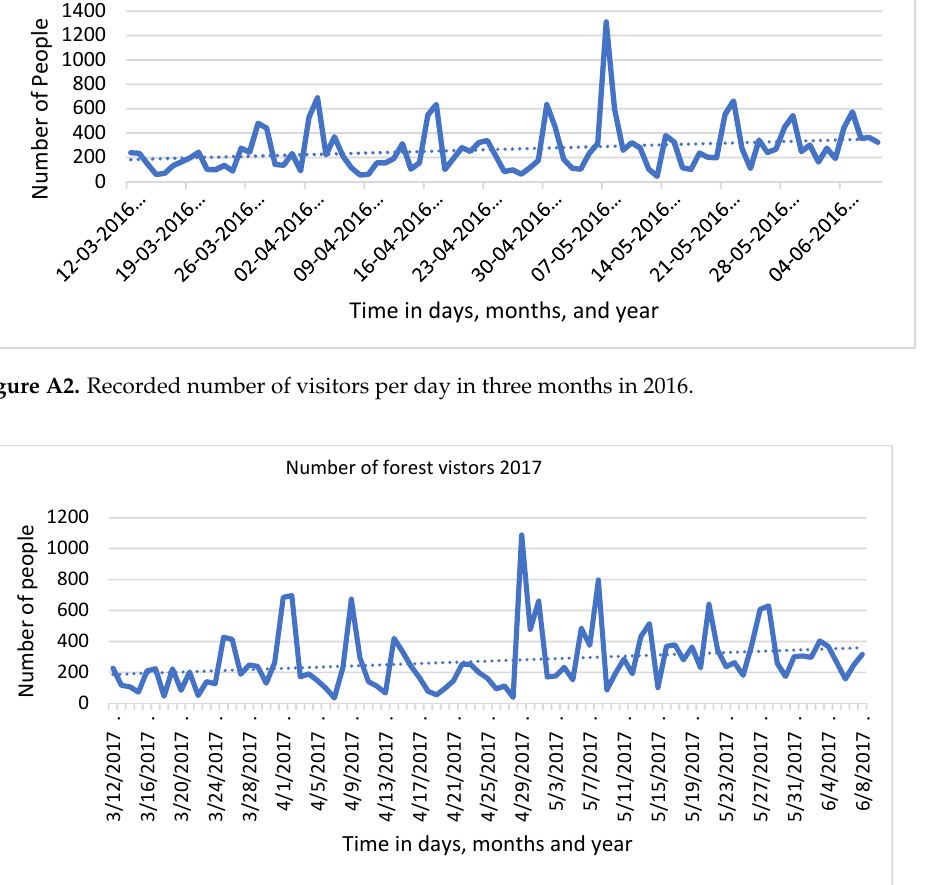
Figure A4. Recorded number of visitors per day in three months in 2018. Figure A5. Recorded number of visitors per day in three months in 2021.